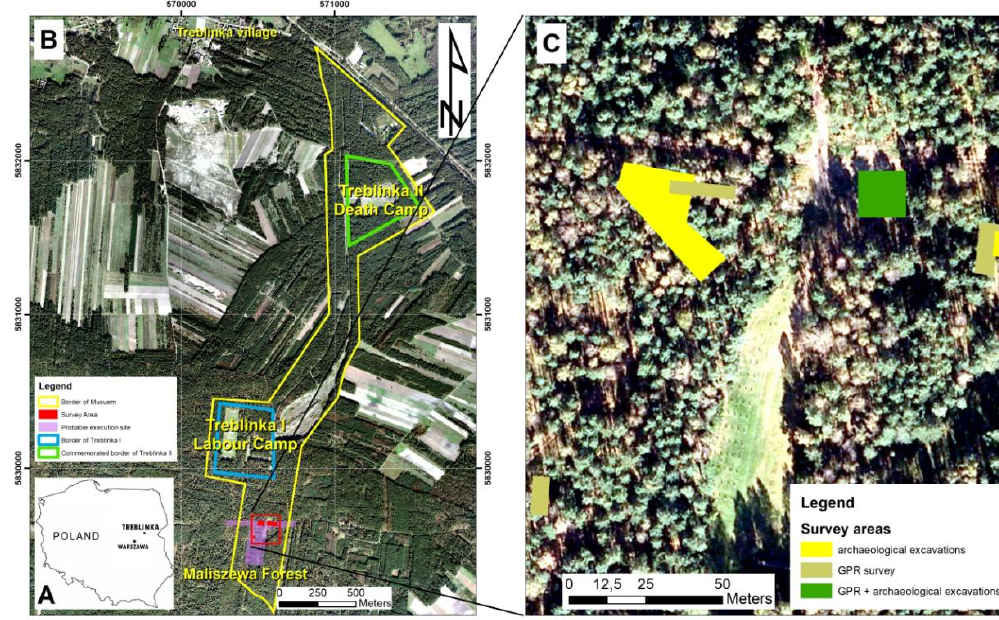
Figure 1. ( A ) Geographical location and ( B ) aerial view of the area of former Treblinka I and Treblinka II camps. The investigated area with geophysical surveys and archaeological excavations is highlighted with red rectangles. The yellow polygon shows the border of the Museum in Treblinka. The blue polygon shows the border of the former Treblinka Labour Camp reconstructed using a 1944 aerial photo. The green polygon shows the actual commemorated border of Treblinka II extermination camp. The cyan rectangle marks the probable area of execution and burials. ( C ) Magnification of the area in which geophysical surveys and archaeological excavations were conducted. Coordinate grid: Polish Coordinate System 1992 (EPSG: 2180). Copyright: Head Office of Geodesy and Cartography in Poland.